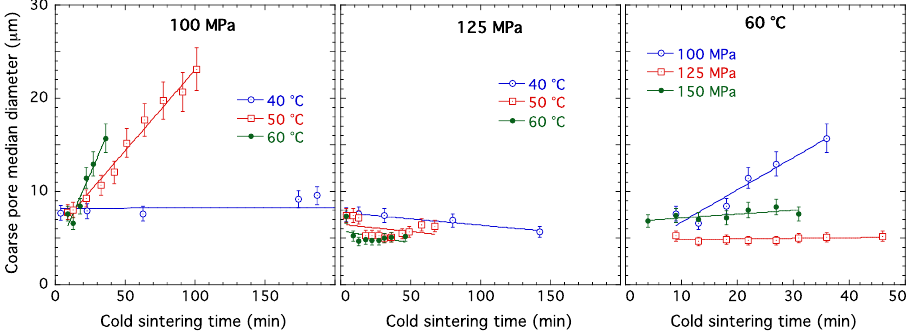
Figure 5. Coarse pore median diameter versus cold sintering time for 40 °C, 50 °C, 60 °C with p = 100 MPa and 125 MPa, and for p = 100 MPa, 125 MPa, 150 MPa at 60 °C. Straight-line fits are simply guides to the eye. The 60 °C data for all 3 stresses are plotted out to just 50 min to show more clearly the different variations with time.